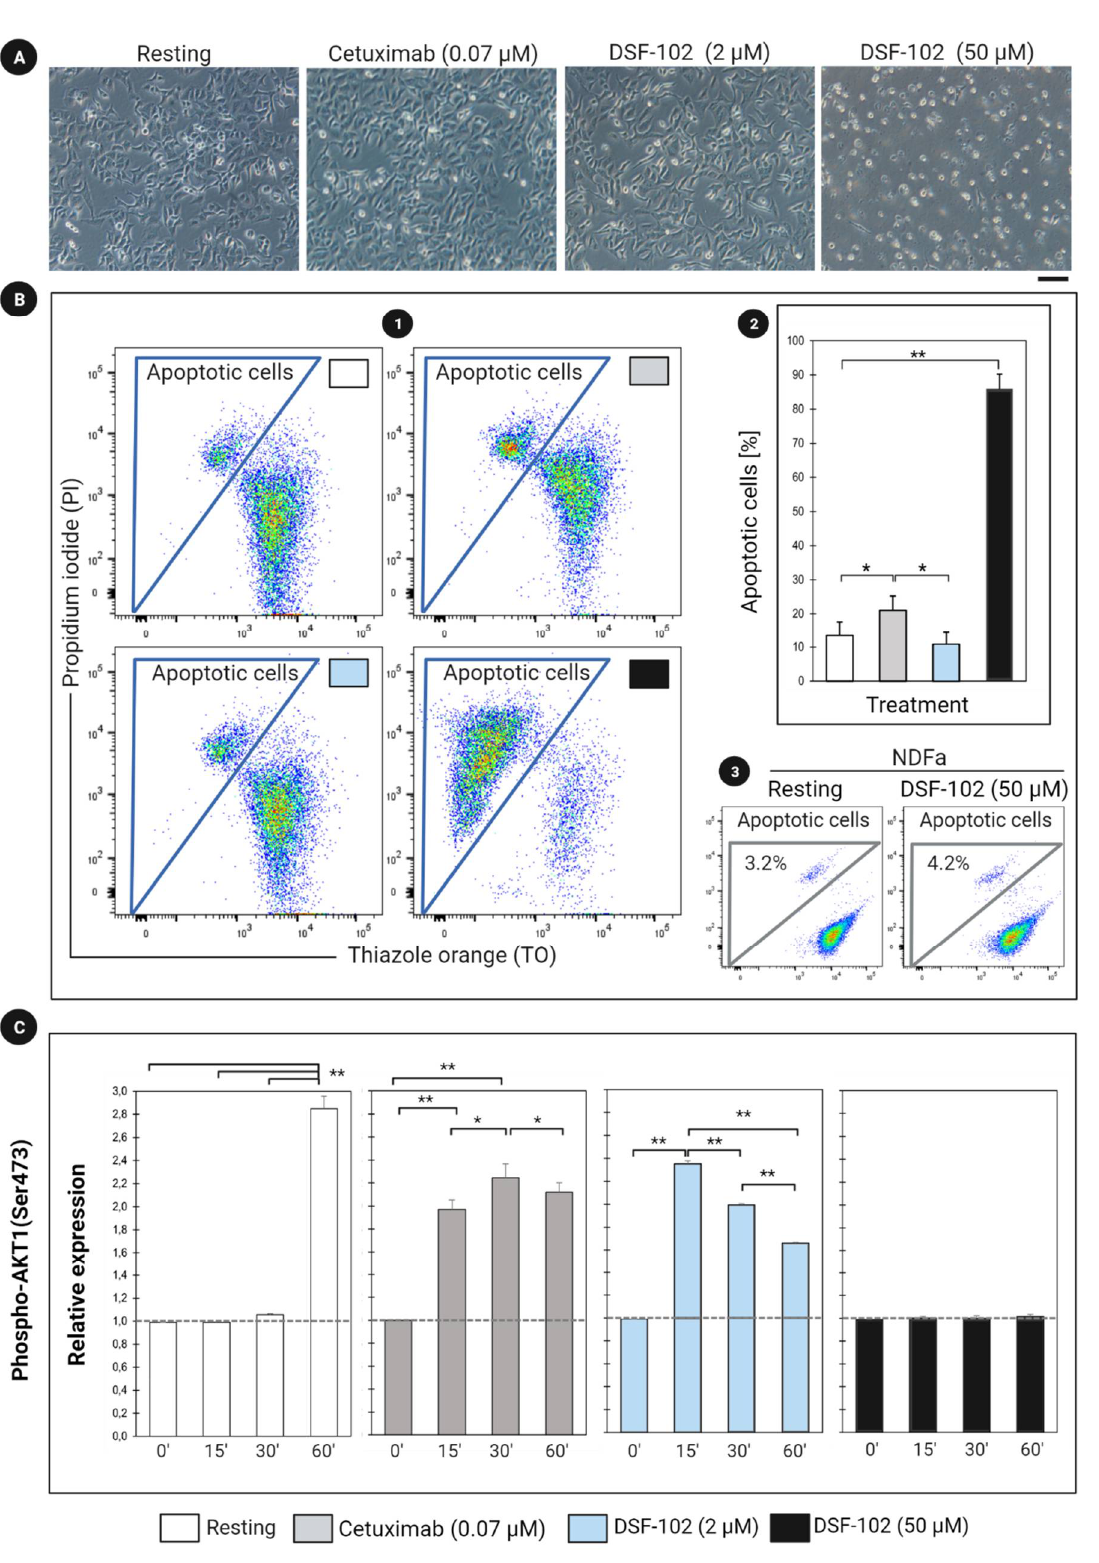
Figure 4. Study of the biological activity of DSF-102 (2 µ M or 50 µ M) on A549 cell line. Assessment of cell death by ( A ) optical microscopy analysis (scale bar: 25 µ m) and ( B ) apoptosis analysis by flow cytometry after 24 h of stimulation. A549 cells kept under resting conditions or treated with cetuxi- mab (0.07 μM) (B1, B2), or primary dermal fibroblasts (NDFa) (B3) were used as controls. Percentage of apoptotic cells were discriminated using TO/PI assay according to the manufacturer’s